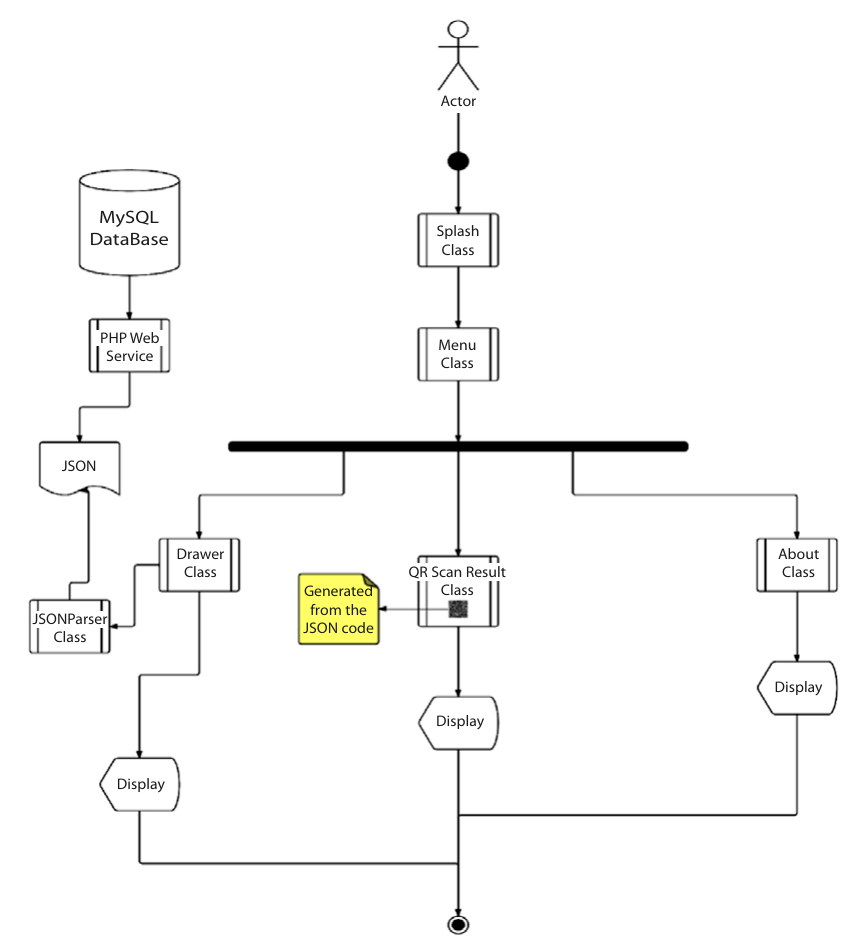
Fig. 3. Use-case flow of the